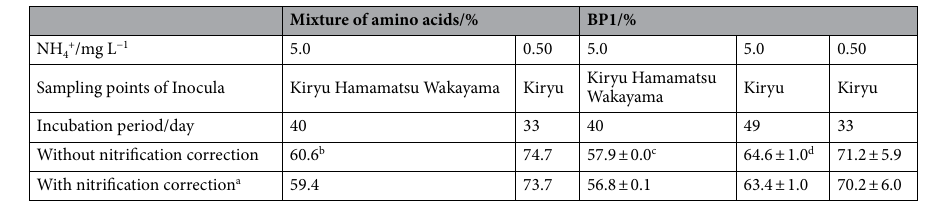
Table 3. BOD biodegradability of the mixture of amino acids and BP1 with and without nitrification correction. a corrected by ion chromatography using the resulting solution after each period. b 58.1 % at 33